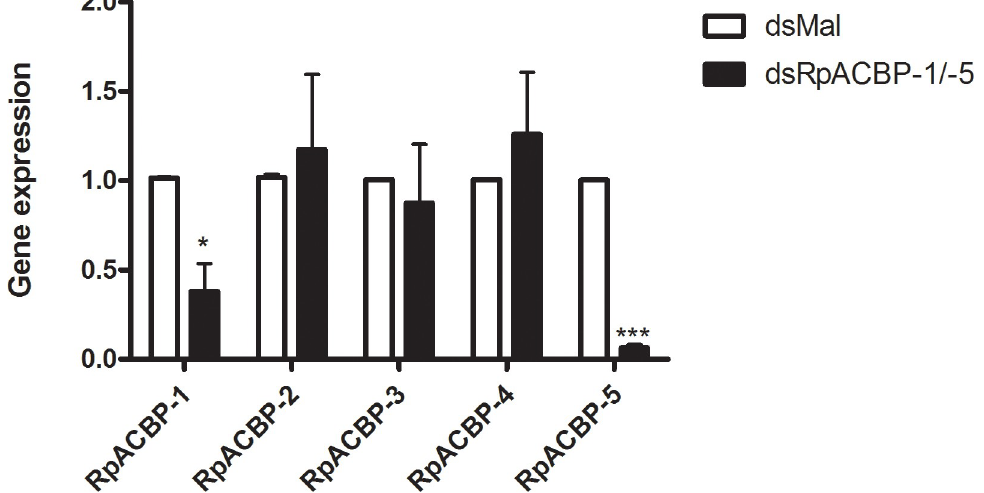
Fig 11. RpACBP-1 / RpACBP-5 double knockdown does not affect expression of the other RpACBP genes. Fasting adult females were injected with a mixture of dsRNAs containing 1 μ g of dsACBP-1 plus 1 μ g of dsACBP-5 (dsRpACBP-1/5), or with 2 μ g of dsMal, used as a control. The insects were fed three days later and dissected at the fourth day after blood meal. Posterior midguts were obtained and homogenized. Samples were subjected to qPCR, for determination of RpACBP-1 , RpACBP-2 , RpACBP-3 , RpACBP-4 , and RpACBP-5 mRNA levels, using Rp18S expression as reference gene. The bars are means ± SEM. ( � ), and ( ��� ): significantly different from dsMal by Student’s t -test with p < 0.05 and 0.001, respectively; n = 4 (except: RpACBP-3 , n =